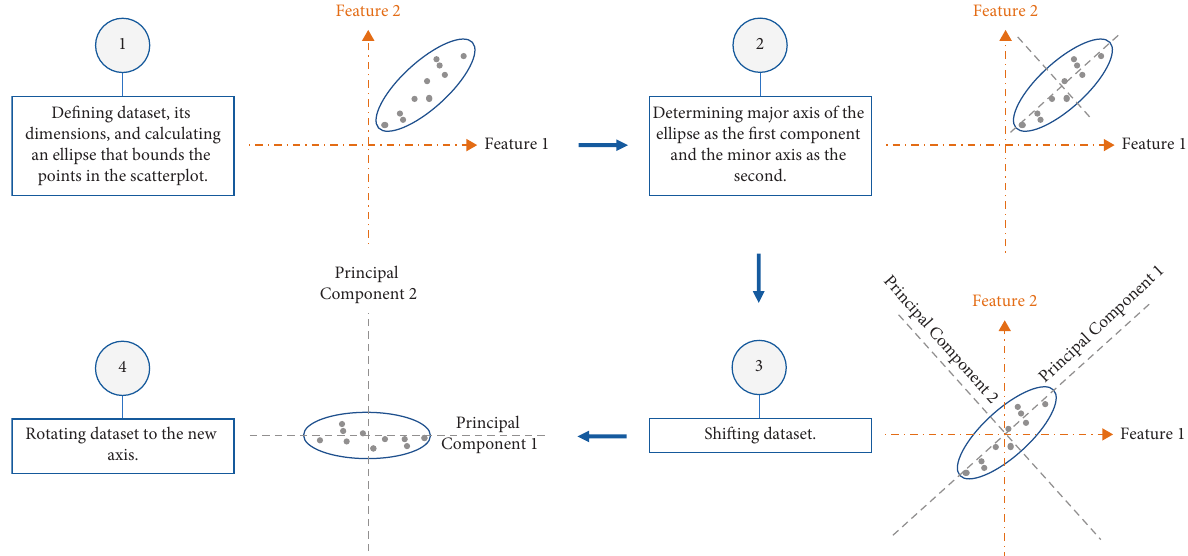
Figure 10: Flowchart of basic operations related to PCA.